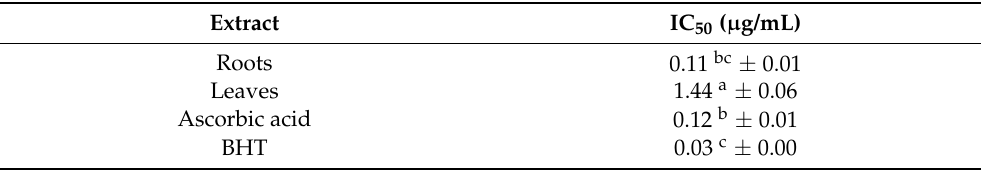
Table 1. IC 50 (50% effective concentration) of ascorbic acid, BHT, and extracts of Anchusa italica , using the FRAP